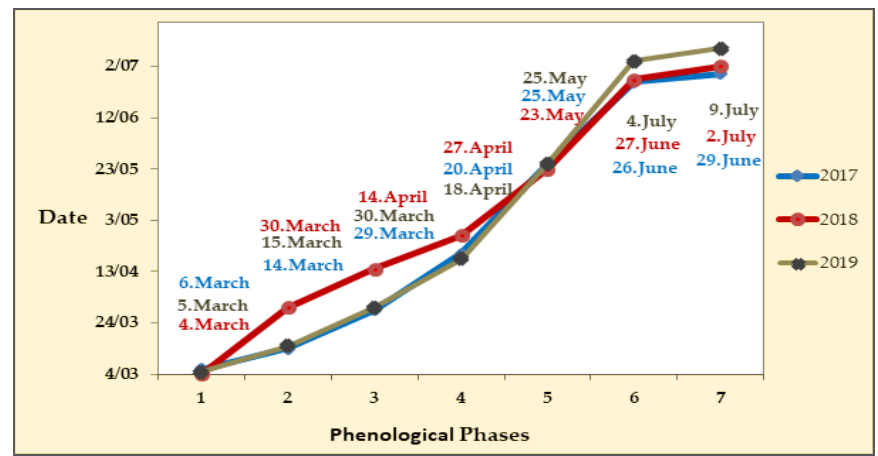
Figure 2. The dates of the beginning of black oat phenophases in chernozem and humogley soil types (2017–2019). Phenophases: 1—sowing (BBCH 00); 2—frst leaf through coleoptile germination (BBCH 10); 3—the beginning of tillering (BBCH 21); 4—the beginning of stem elongation (BBCH 30); 5-the end of heading (BBCH 59); 6-soft dough (BBCH 85); 7—fully ripe (BBCH